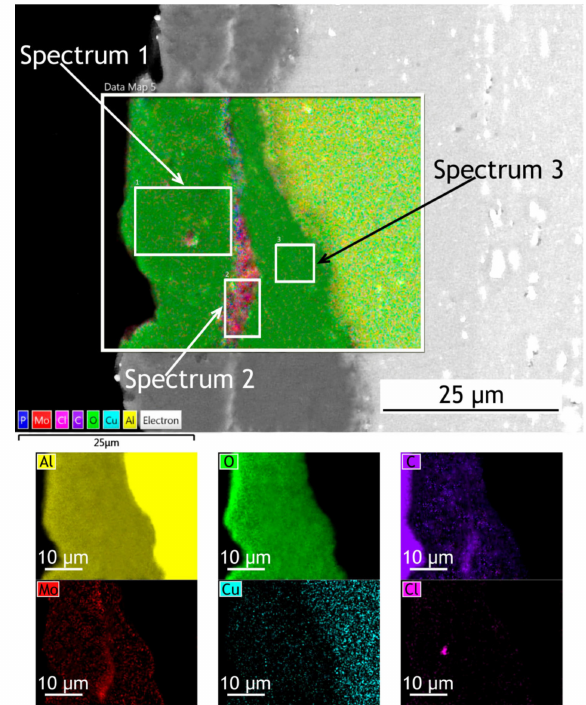
Figure 16. SEM image and EDX maps of the PEO-coating’s cross-section after 30 days of marine immersion.